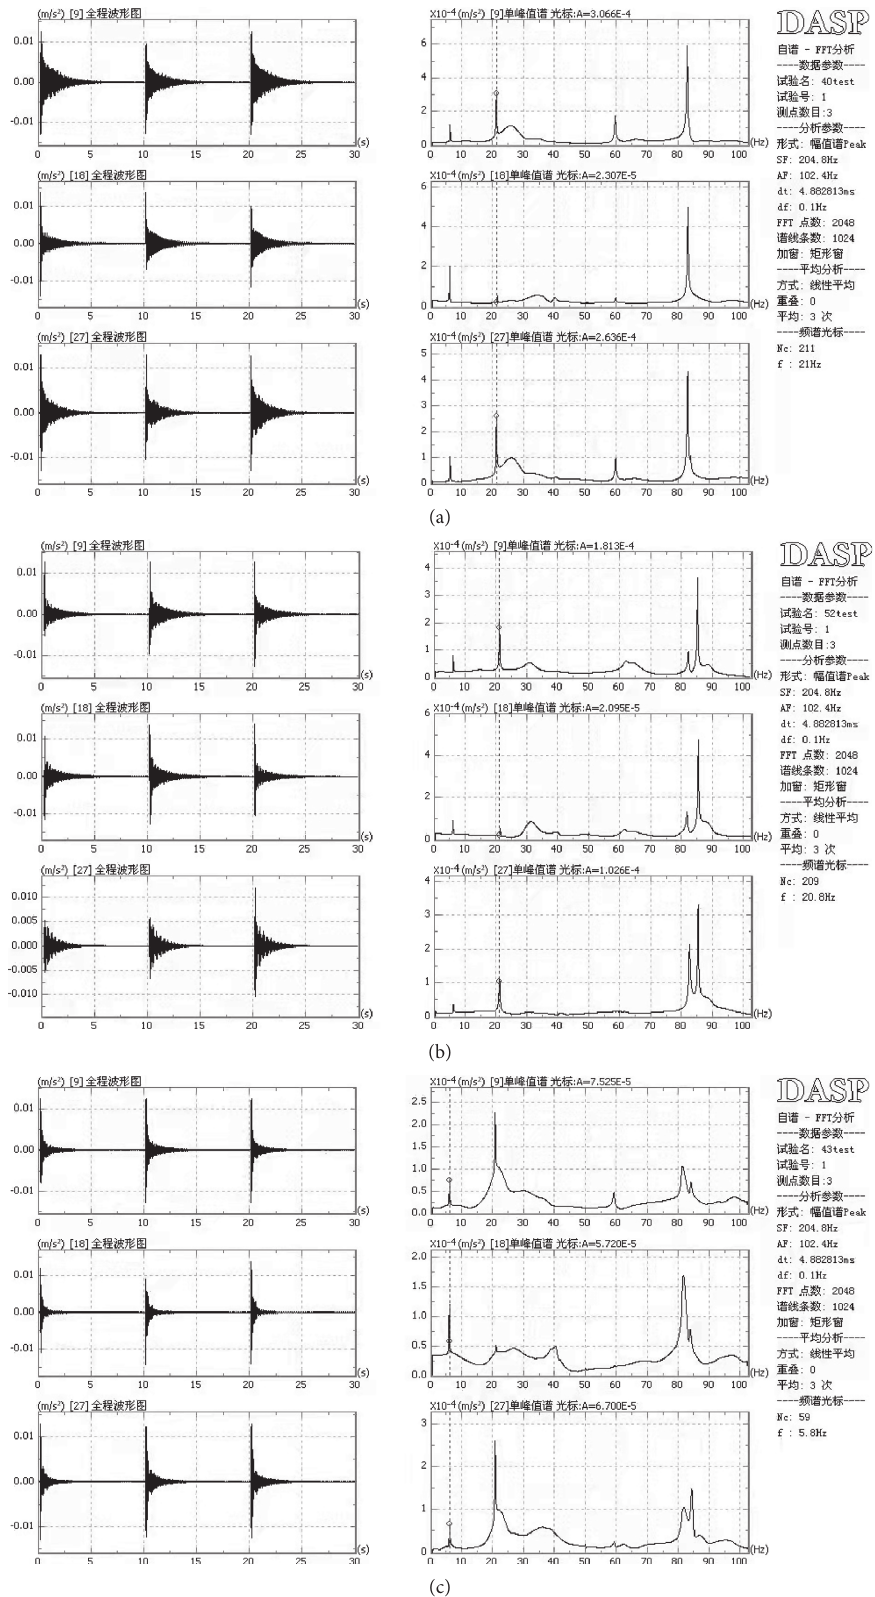
Figure 29: Frequency spectrum curve of simply supported beam. (a) Form 1. (b) Form 2. (c) Form